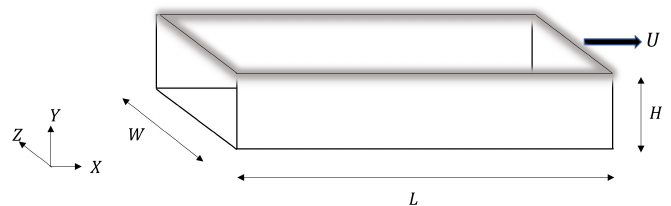
Figure 9. Schematic of the 3D shallow cuboid cavity of dimensions L × H × W